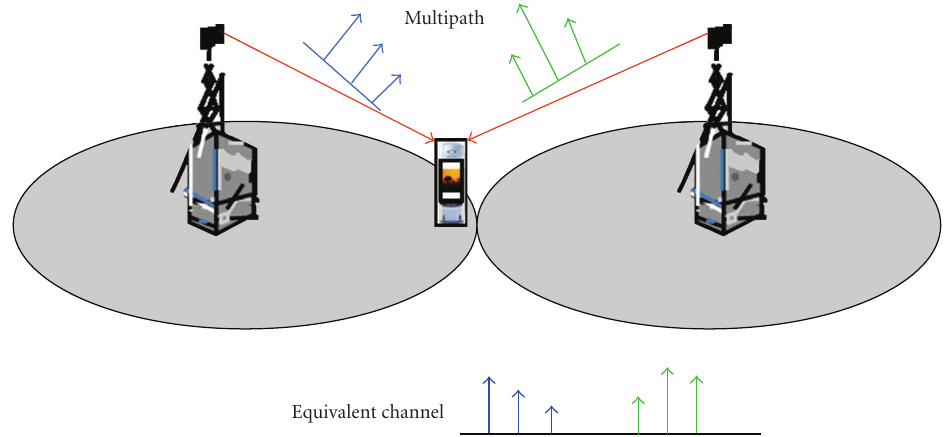
Figure 17: Principle of MBMS transmission with a common transmitted